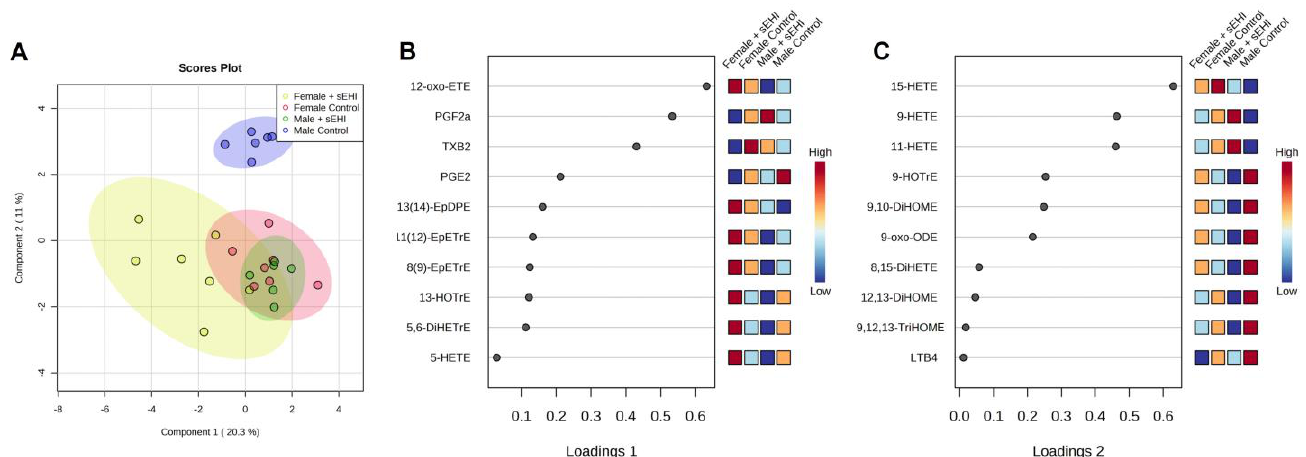
Figure 6. sPLS-DA of the oxylipin profiles of male and female control and sEHI-treated mice: ( A ) sPLS-DA plot of female sEHI-treated (color-coded yellow), female control (color-coded red), male sEHI-treated (color-coded green), and male control (color-coded blue) oxylipin profiles. ( B ) Loadings plot for the ten variables included in component one of the sPLS-DA. ( C ) Loadings plot for the ten variables included in component two of the sPLS-DA. For definitions of oxylipin abbreviations see Table S1.